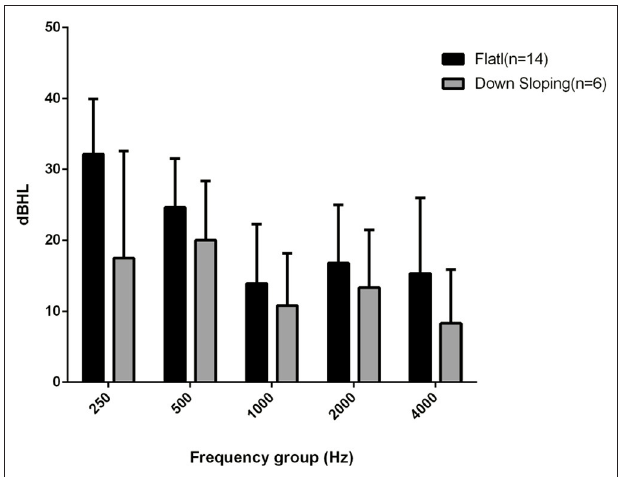
FI-AMEI Efficacy at Activation and at the Last Follow-Up The mean PTA implant values at activation were 25.5 dB HL at 250 Hz, 35 dB HL at 500 Hz, 39 dB HL at 1,000 Hz, 44 dB HL at 2,000 Hz and 72 dB HL at 4,000 Hz. The mean PTA implant values at the last follow-up were 43.25 dB HL at 250 Hz, 50.5 dB HL at 500 Hz: 57.25 at 1,000 Hz, 61.75 dB HL at 2,000 Hz and 79.25 dB HL at 4,000 Hz. The mean PTA implant gain at activation with respect to the BC threshold was 13 dB HL, and at the last follow-up, with respect to the follow-up BC threshold at the different frequencies, it was 19 dB at 250 Hz, 20 dB at 500 Hz, 18 dB at 1,000 Hz, 21 dB at 2,000 Hz, and 3 dB at 4,000 Hz ( Figure 4 ), with a mean gain of 16.2 dB HL ( Figure 5 ). The mean SRT was 76.75 dB HL preoperatively, 57.75 dB HL at activation, and 69.25 dB HL at the last follow-up. The